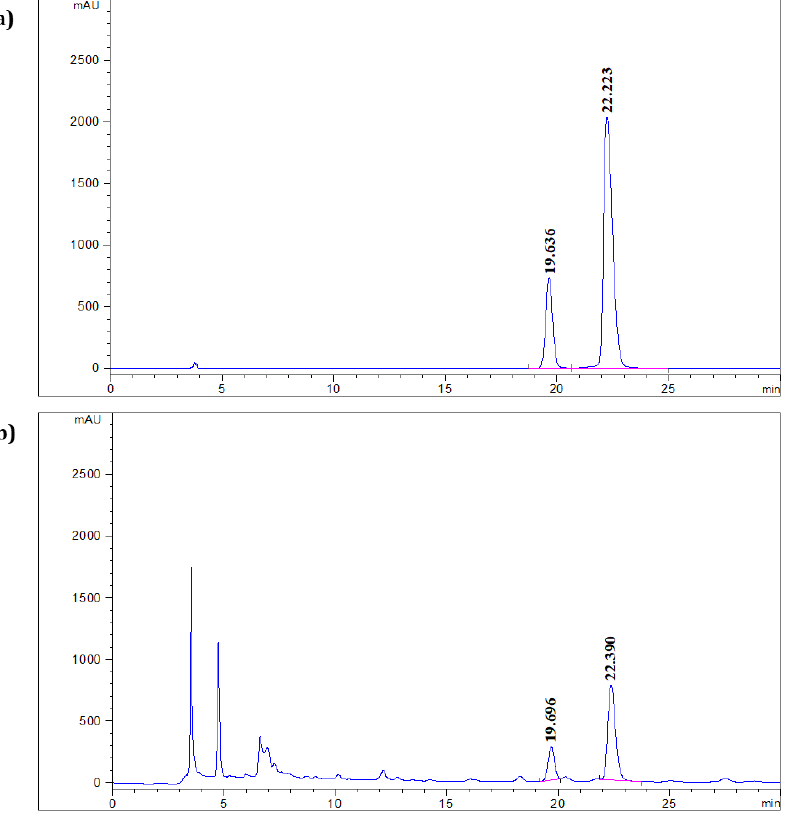
Figure 2. HPLC chromatogram of ( a ) mixed standard of quercetin-3- O -glucuronide (19 min) and ellagic acid (22 min), and ( b ) ethanol extract of O. biennis sprout.